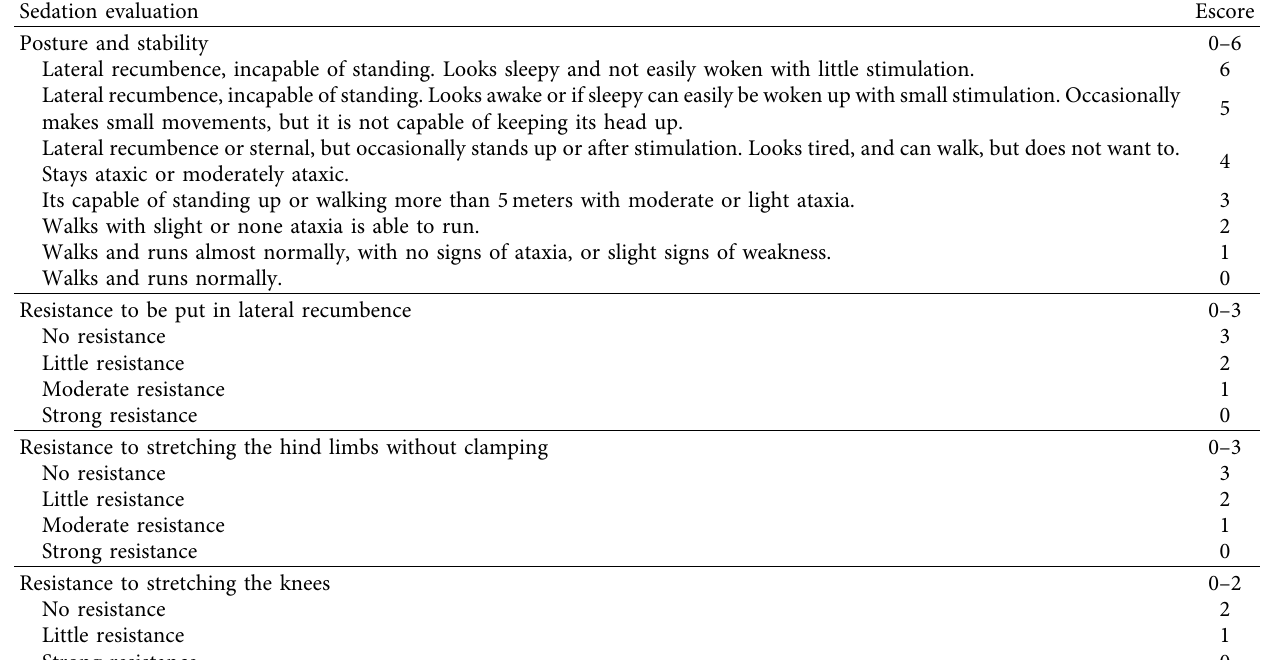
Table 1: Simple descriptive analysis of sedation, muscle relaxation, and analgesia in felines. Sedation